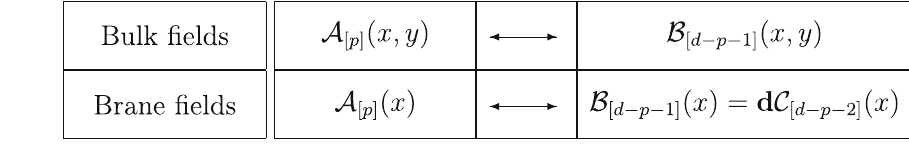
Fig. 1 Equivalency relation (indicated by the arrows) between the bulk fields, and also, between the effective brane fields after the dimensional